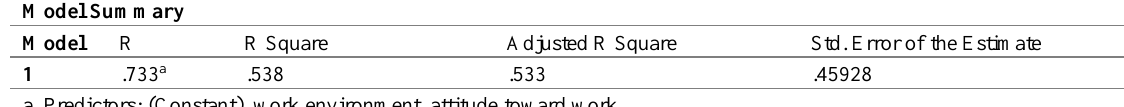
Table 8: Relationship between attitude toward work, work environment, and Self-efficacy